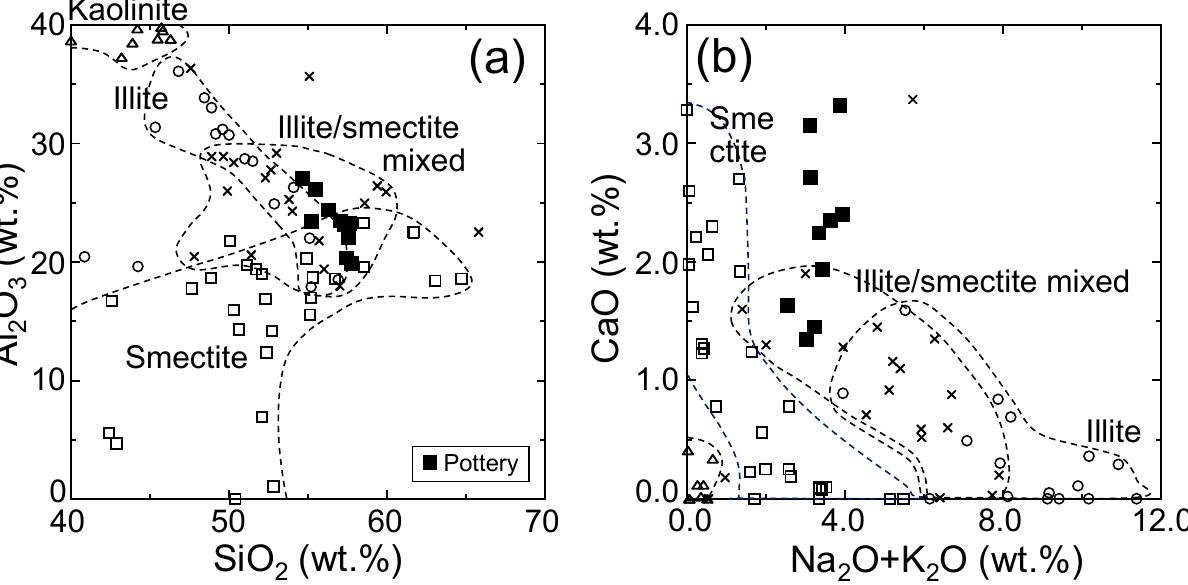
Figure 8. ( a , b ) Correlations of oxide contents in pottery clay pastes and representative clay minerals (kaolinite, illite, smectite, and illite/smectite mixed-layer clay minerals). Solid squares, clay paste from pottery samples; open triangles, kaolinite [41]; open circles, illite [41]; open squares, smectite [41]; crosses, illite/smectite mixed-layer clay minerals [41]. ( a ) SiO 2 vs. Al 2 O 3 and ( b ) Na 2 O + K 2 O vs. CaO.